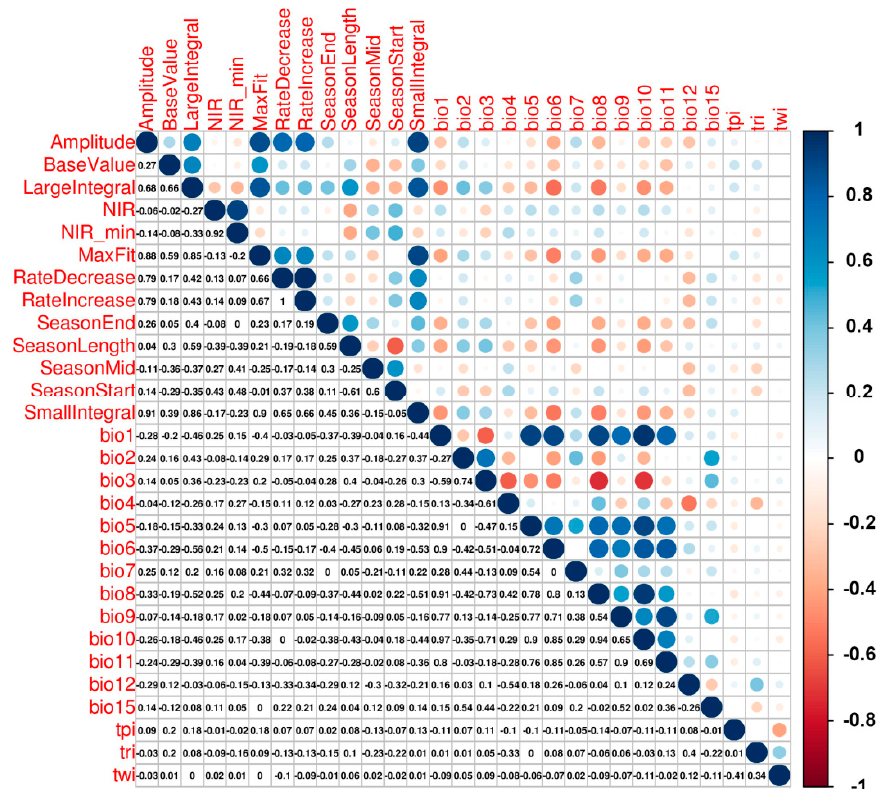
Figure 2. Correlation matrix of predictor variables measured by Spearman’s rank-correlation coefficient (r s ) ranging from − 1 to 1. The lower half of the diagonal gives the numeric value of r s ; the upper diagonal visualizes the correlation coefficient: the size of the circles corresponds to the strength of the correlation; red denotes negative and blue positive correlation coefficients. For details on predictor variables, see Table 1. Table 2. Validation results for the two model types boosted regression trees (BRT) and random forests (RF) on the three subsets of the predictor variables: remote sensing and topography (“ RS TOPO ”), only climate data (“ CLIMATE ”) and all data (“ ALL ”). The following performance measures were calculated: explained variance (expl. var. (%)), Pearson’s correlation coefficient (r p ) between observed and predicted values, the coefficient of determination (R 2 ), the root mean square error (RMSE, in species per 10 3 m 2 ), and the relative root mean square error (rRMSE in percent). The results for training and test data are displayed (training 80% of the data andtesting 20%). Expl. var. Model Dataset BRT RS TOPO